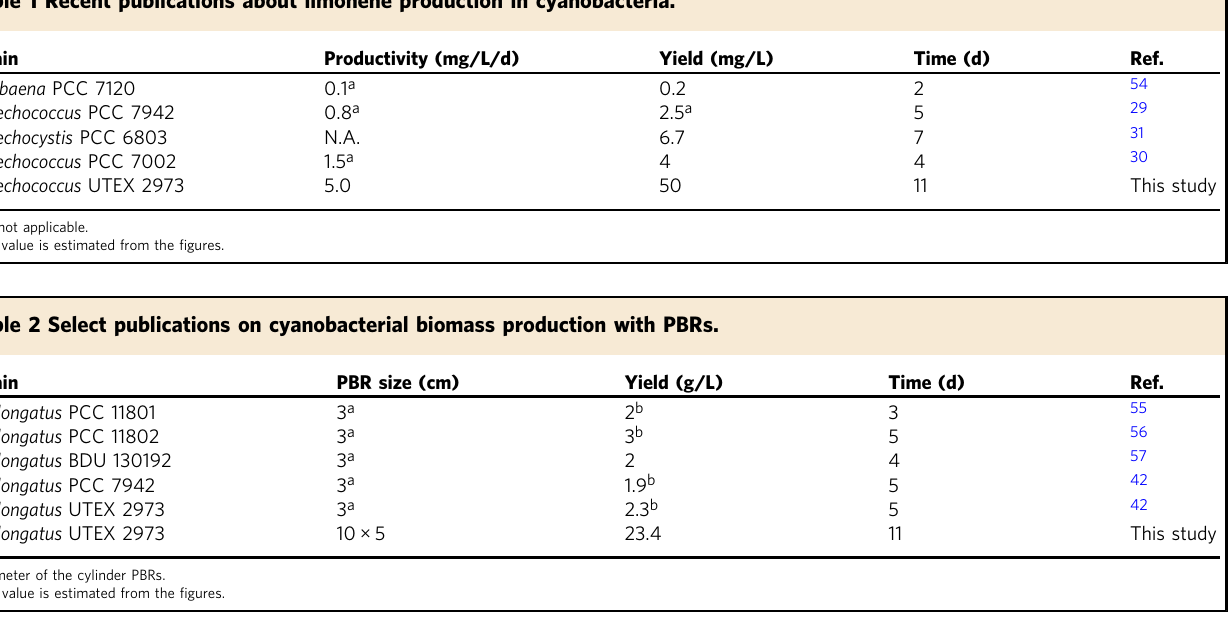
a Diameter of the cylinder PBRs. b The value is estimated from the fi